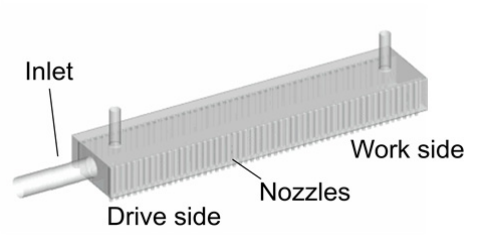
Figure 1. The model water manifold considered in this paper .